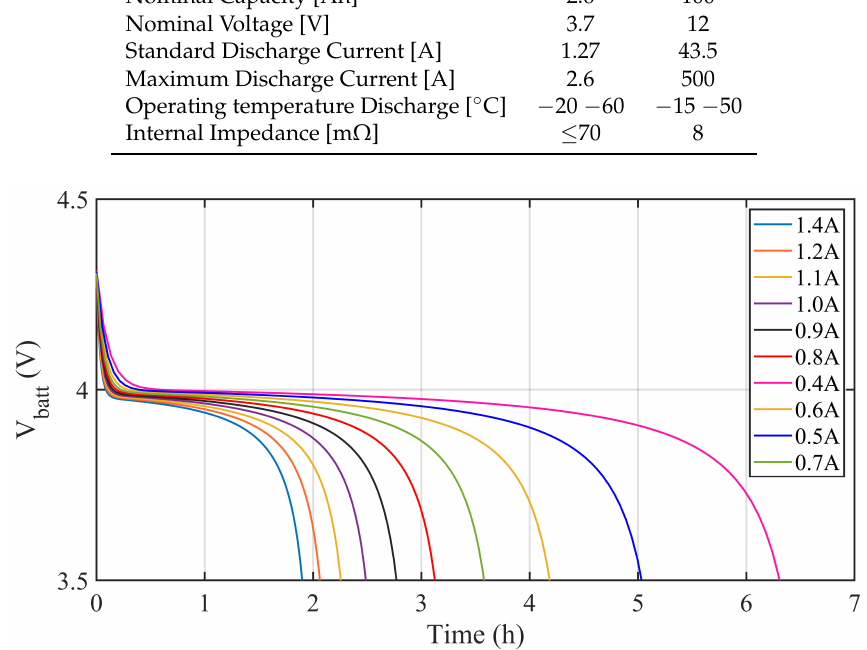
Figure 2. Discharge characteristics of Li-ion battery having a nominal voltage V n = 3.7 V and a rated capacity C c = 2.6 Ah for different values of discharge